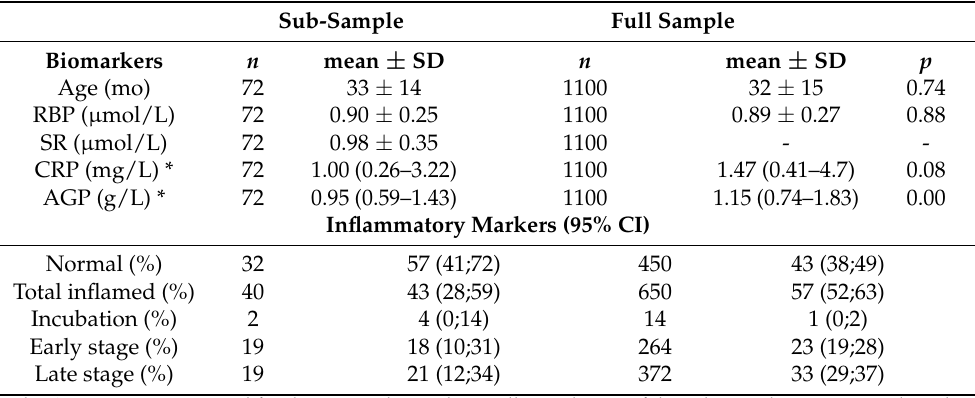
Table 1. Characteristics of vitamin A and inflammatory biomarkers in the sub-sample used for linear regression of pre-school children in Malawi .